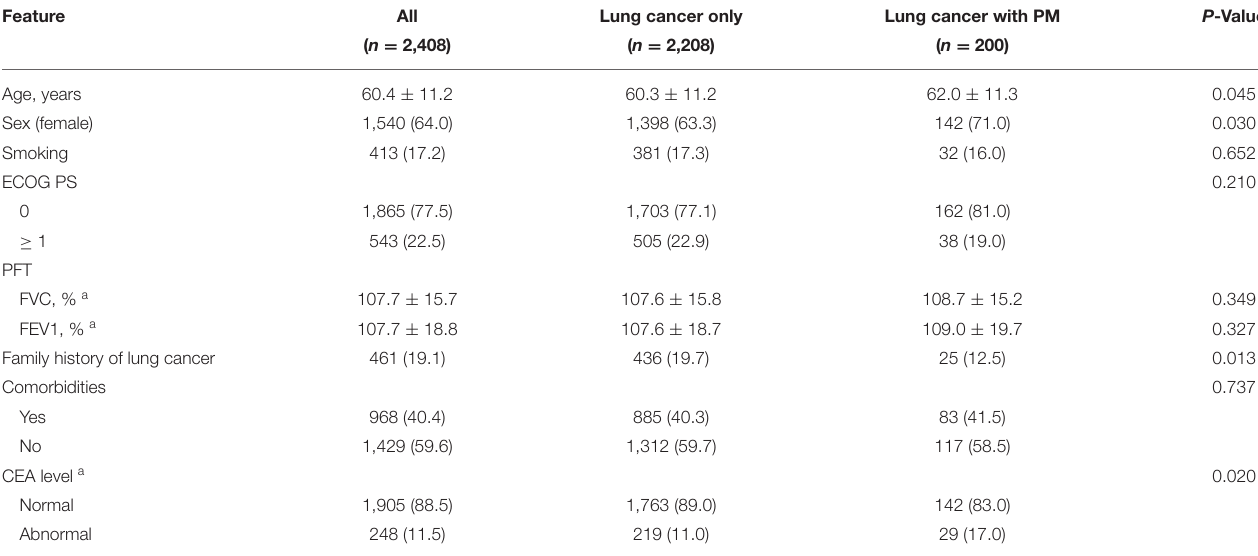
TABLE 1 | Demographic and clinical